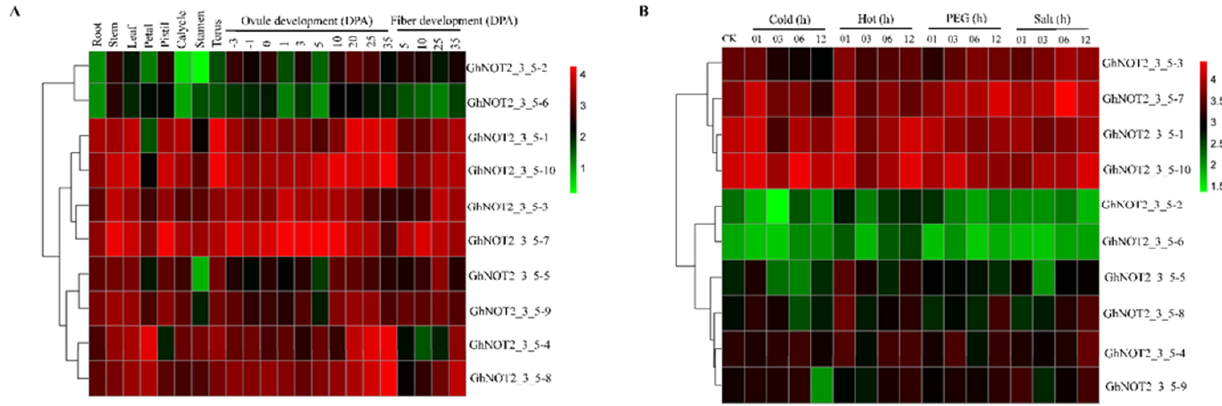
Figure 6. Heat maps of expression patterns of NOT2_3_5 genes. ( A ) Expression patterns of NOT2_3_5 genes in different tissues of G. hirsutum. ( B ) Expression patterns of NOT2_3_5 genes under different stresses of G. hirsutum .